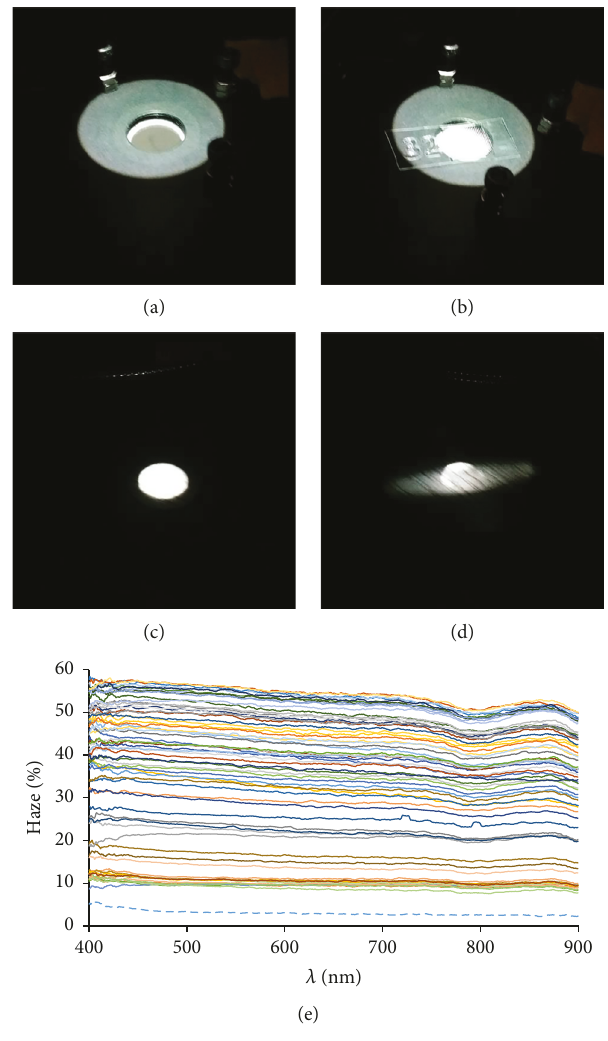
Figure 7: (a – d) Photographs showing the directional scattering caused by the laser-processed PET (b, d) relative to having no sample (a, c). The sample used for this image has a speed of 400mm/s, a spacing of 400 μ m, and a power of 20%. The average haze (400 – 750nm) is 43.5%. The graph displays the measured haze of all 64 samples and demonstrates the range of haze values created. The dashed line in (e) is the AR